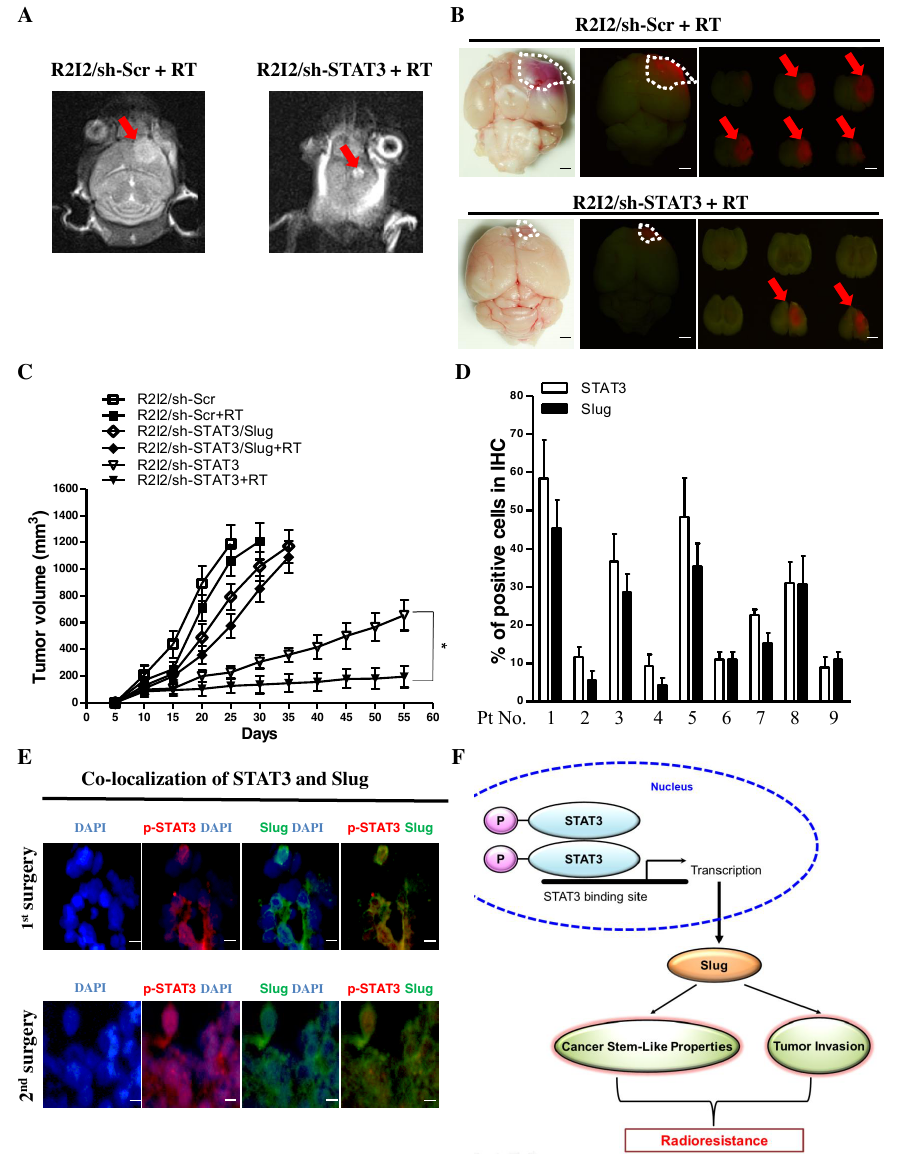
Figure 6. Suppressing the STAT3/Slug axis shows synergistic effects on radiosensitivity in vivo. ( A ) GBM-R2I2 cells were subinjected into NOD-SCID mice intracranially. 3T MRI and ( B ) RFP images show tumor volumes in GBM-R2I2/sh-STAT3 tumor-bearing mice compared with GBM-R2I2/sh-Scr mice after IR (5 Gy). Scale bars: 50 µ m ( C ) The size of tumor volumes in GBM-R2I2 mice treated with sh-STAT3 + 5 Gy IR were significantly smaller than those receiving the other protocols. ( D ) Immunohistochemistry (IHC) staining detected STAT3 and Slug protein in nine GBM patient samples. ( E ) STAT3 and Slug protein colocalization in tissues from Pt1 by immunofluorescent staining. Scale bars: 20 µ m. Blue: DAPI; Green: Slug; Red: p-STAT3. ( F ) Schematic illustration depicting the STAT3/Slug axis associations with cancer stemness and tumor invasion that induce resistance to